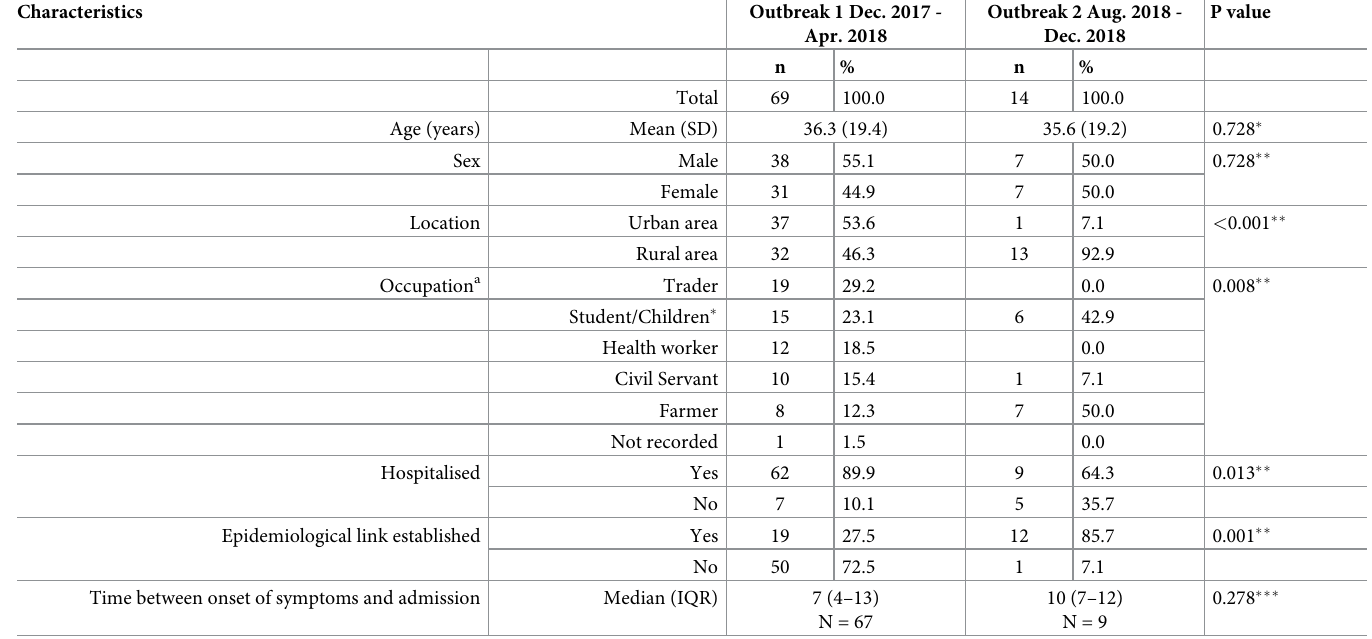
Table 1. Socio-demographic profile of confirmed and probable cases in the two outbreaks.